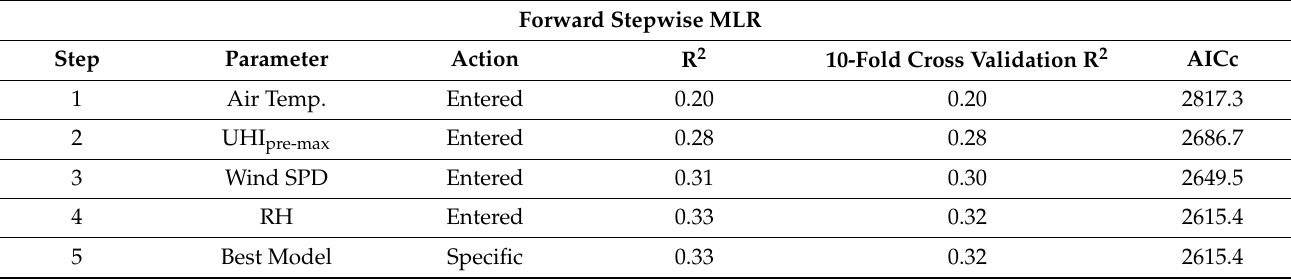
Table 5. Statistical model of UHImax in summer using stepwise MLR (2002–2012, incomplete observations were excluded, * statistically significant).